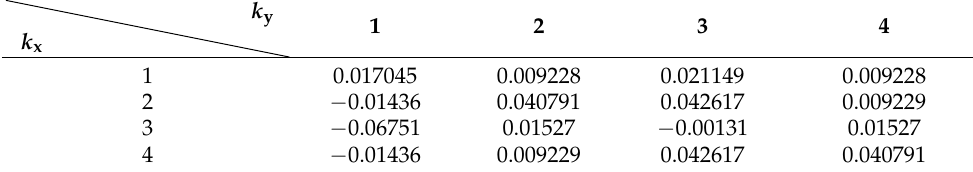
Table 3. Original angular spectrum value.